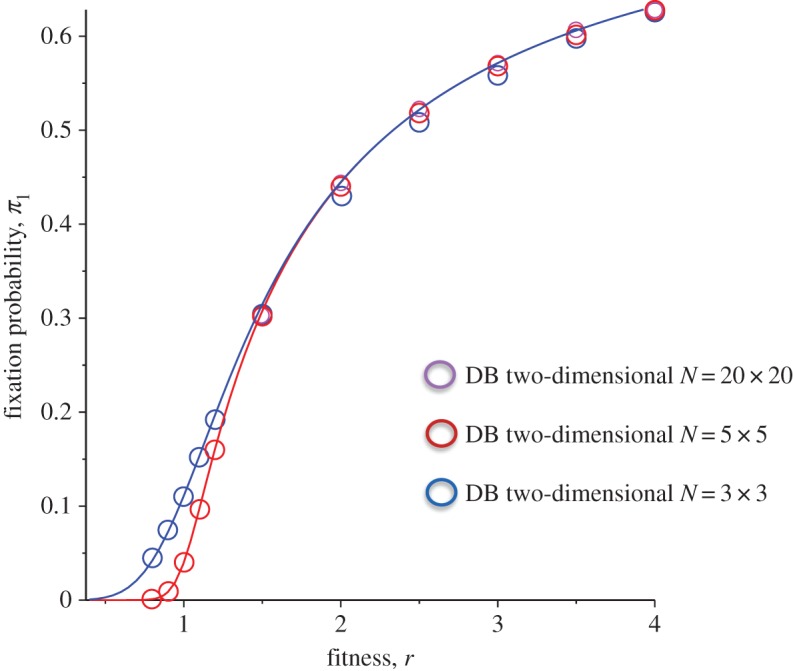
Comparison of analytical results for the fixation probability π1 as a function of the division rate r for a square lattice two-dimensional DB with different lattice sizes cases with k=4 (4-neighbour). Solid lines are analytical results from equation (6.2), while circles are the results of stochastic simulations with 40 000–80 000 iterations (for smaller sizes, we used higher number of iterations to reduce the statistical error).